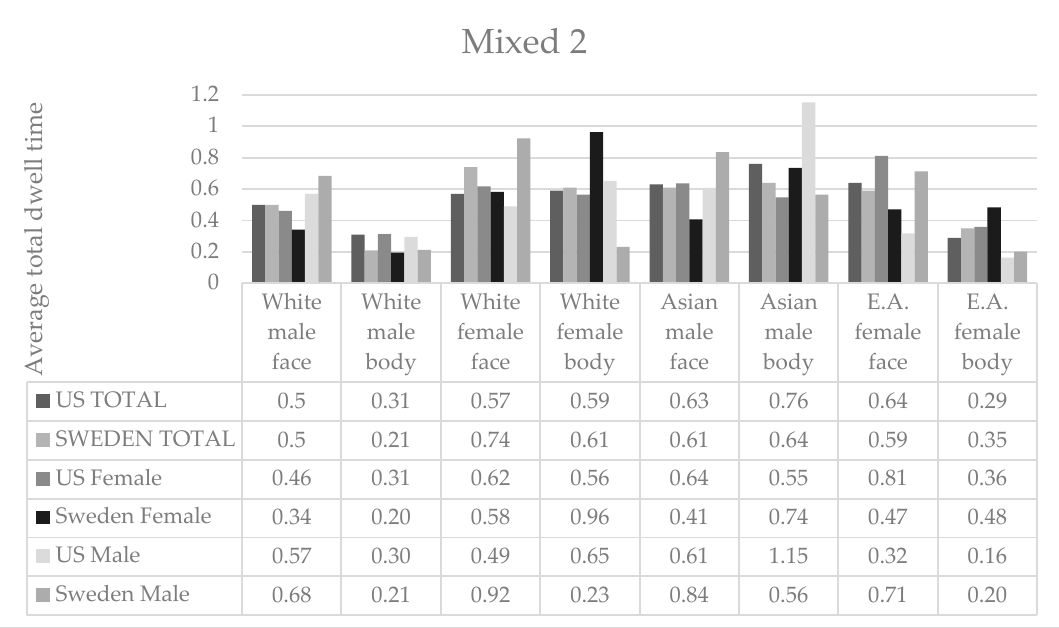
Figure 5. Average total dwell times (s): Mixed 2.